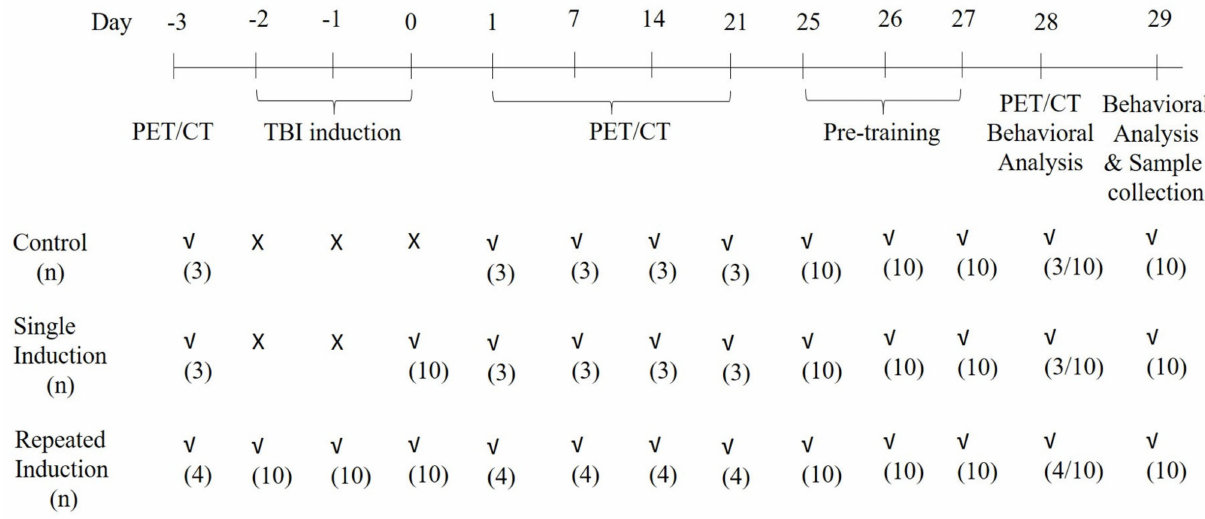
Figure 8. Timeline showing the TBI induction and imaging procedure for the control, single and repeated TBI-induced